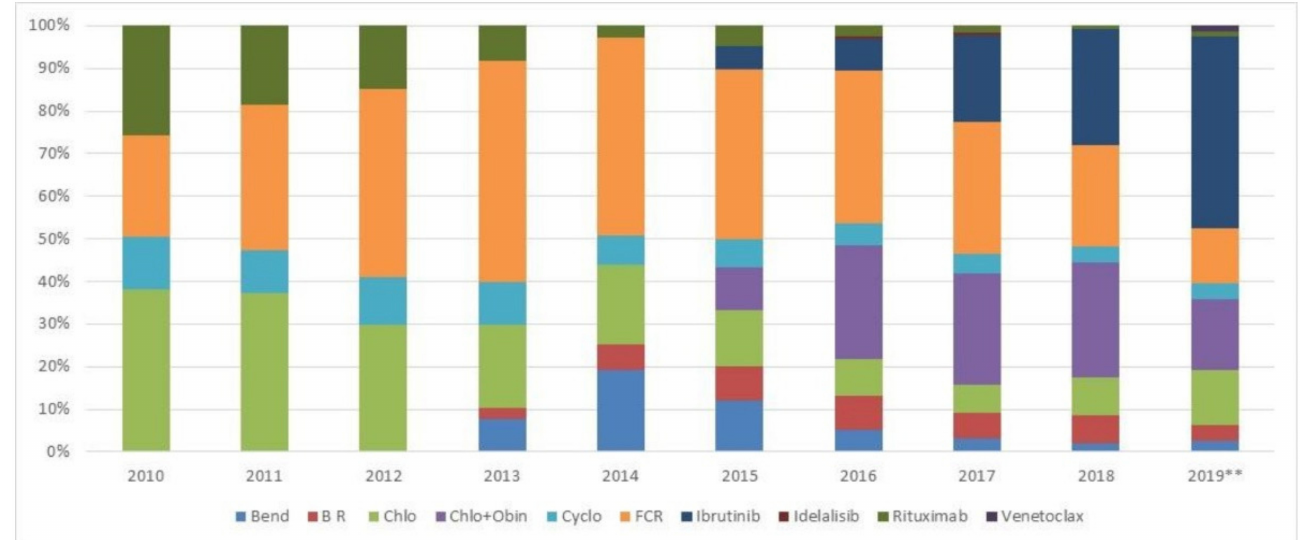
Figure 1. First line treatment regimen received over the years. (Bend: bendamustine; B R: bendamustine + rituximab; Chlo: chlorambucil; Chlo + Obin: chlorambu-cil + obinutuzumab; Cyclo: cyclophosphamide; FCR: fludarabine, cyclophosphamide and rituximab. 2019**: Data available until August